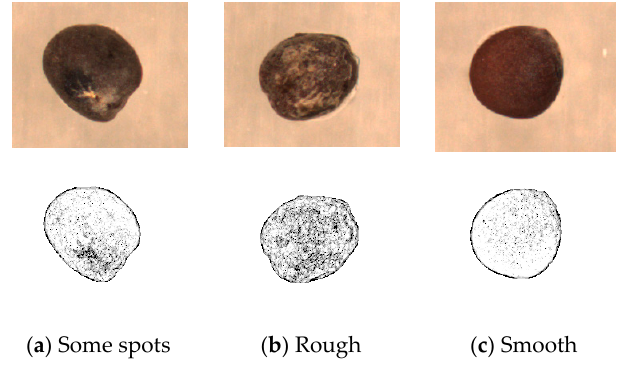
Figure 8. LSP coarseness.